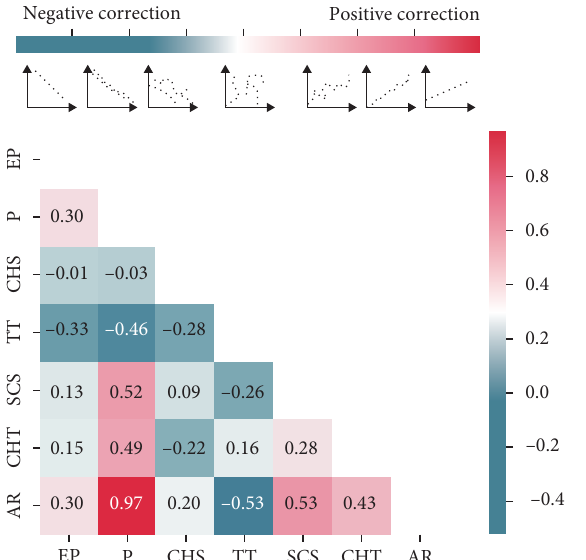
Figure 6: Parameter correlation